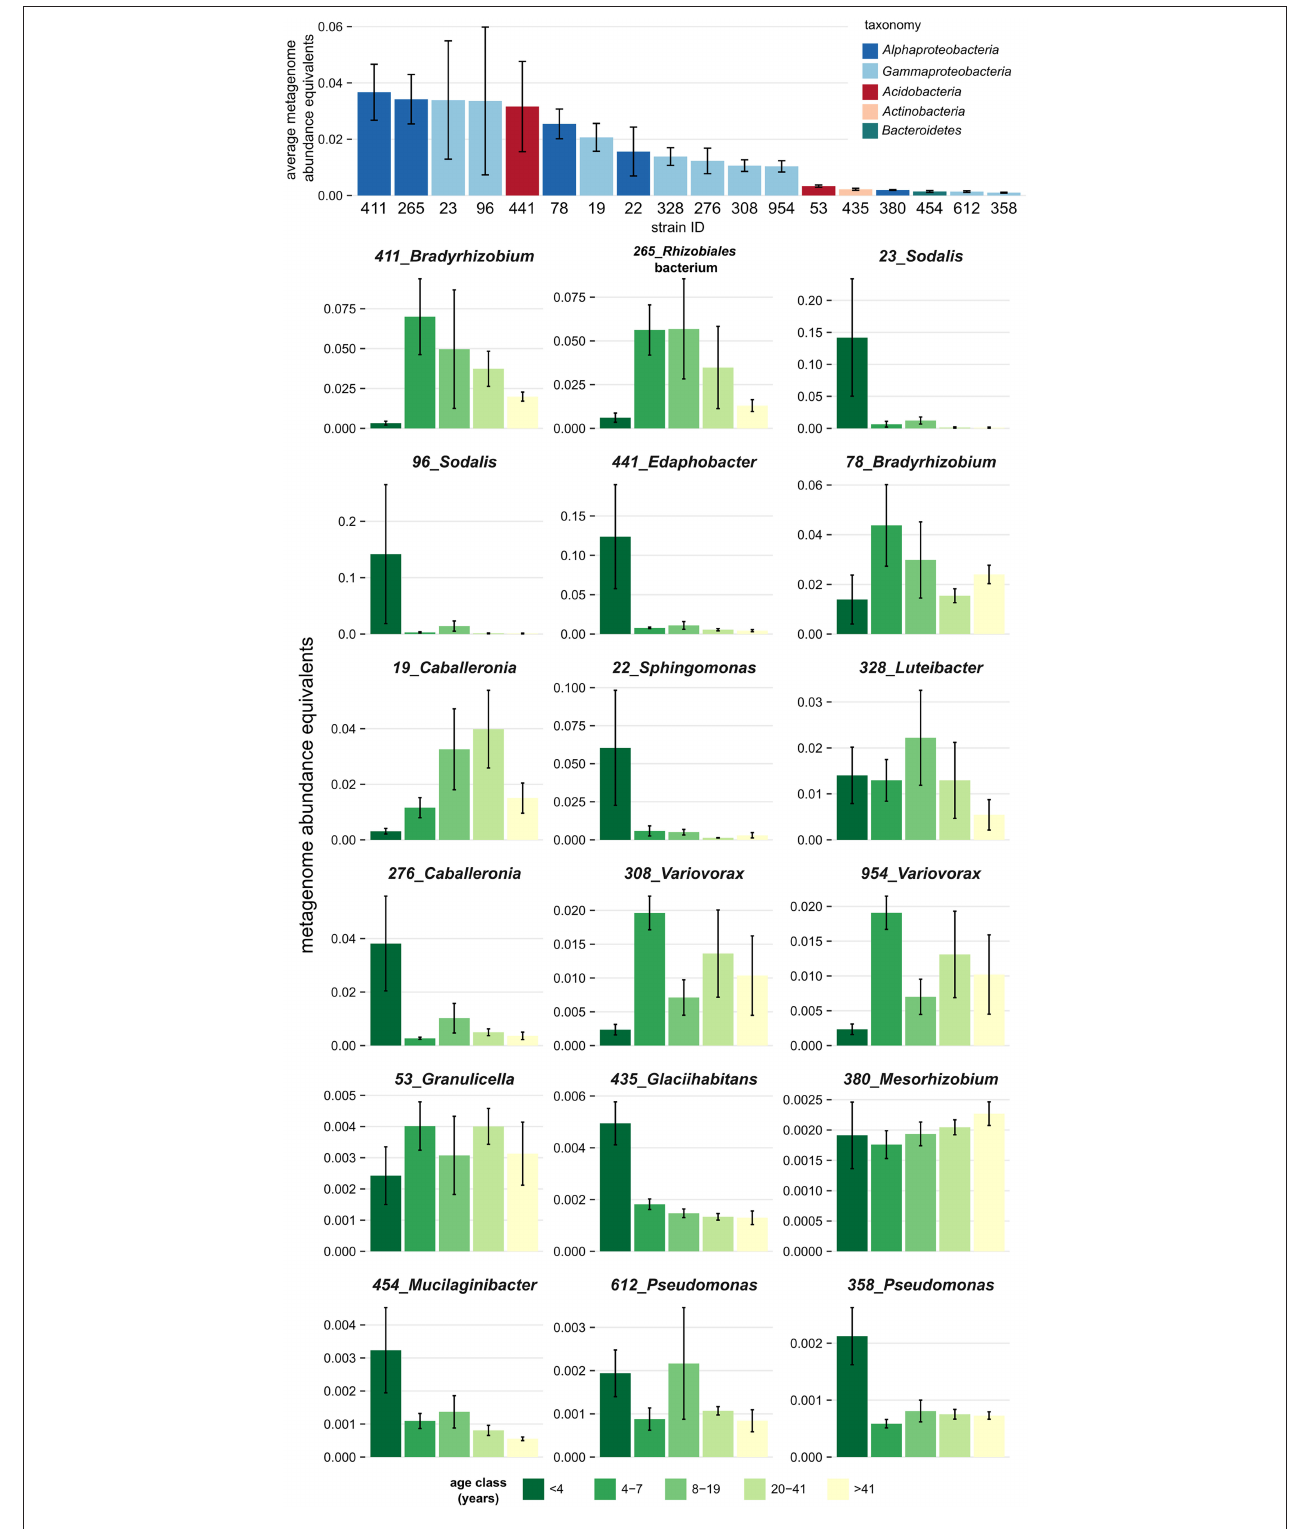
FIGURE 3 | Association of dominant bacteria isolated from decomposing Fagus sylvatica deadwood with a certain age of deadwood. Mapping of the deadwood metagenome reads (Tláskal et al., under review) to genomes of strains shows a distinct overall abundance of these bacteria in metagenomes and distinct occurrence in individual deadwood age classes. Strains are sorted based on the total average metagenome abundance. The height of the bar plots corresponds to abundance equivalents—relative share of mapped reads corrected to the genome size of each strain. Error bars represent standard errors.